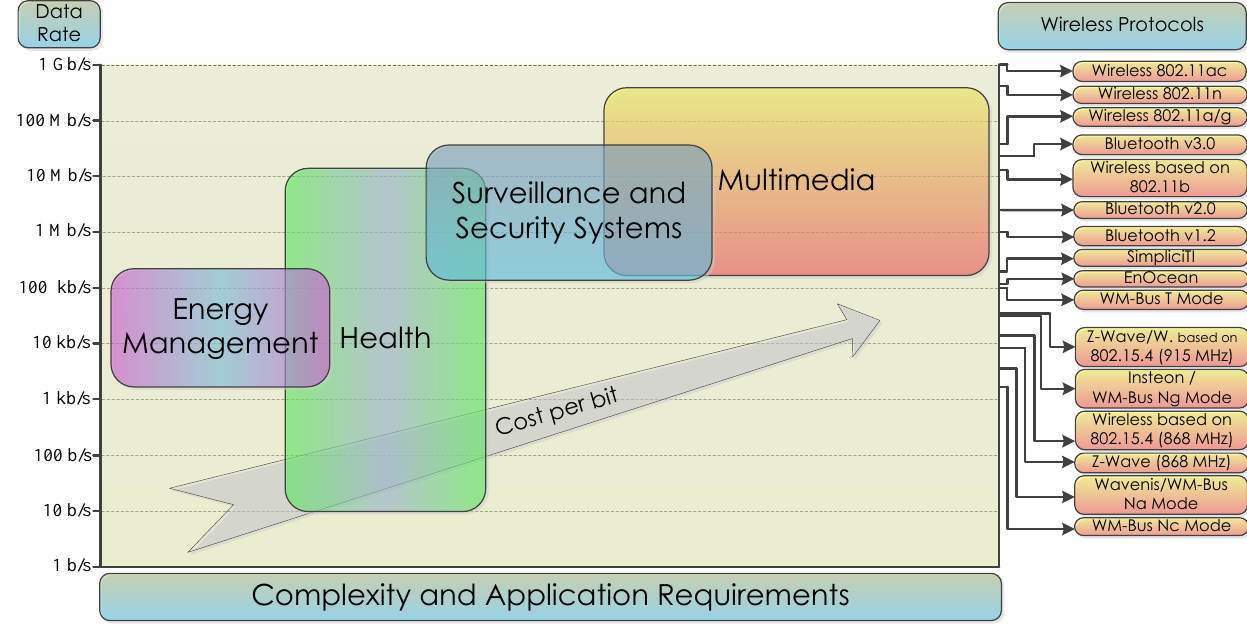
Figure 3. Wireless communication technologies for smart home applications vs . data